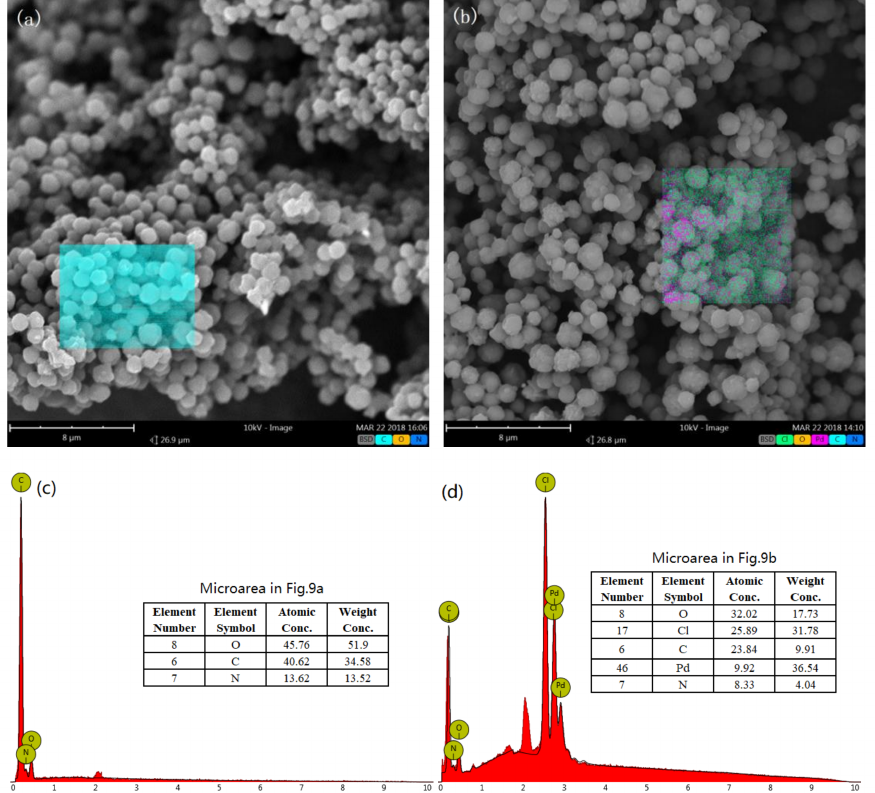
Figure 9. Scanning electron microscopy with energy dispersive spectroscopy (SEM-EDS) analysis of AQ-PGMA and AQ-PGMA-Pd: ( a ) and ( b ) SEM micrographs; ( c ) and ( d ) EDS spectrums.